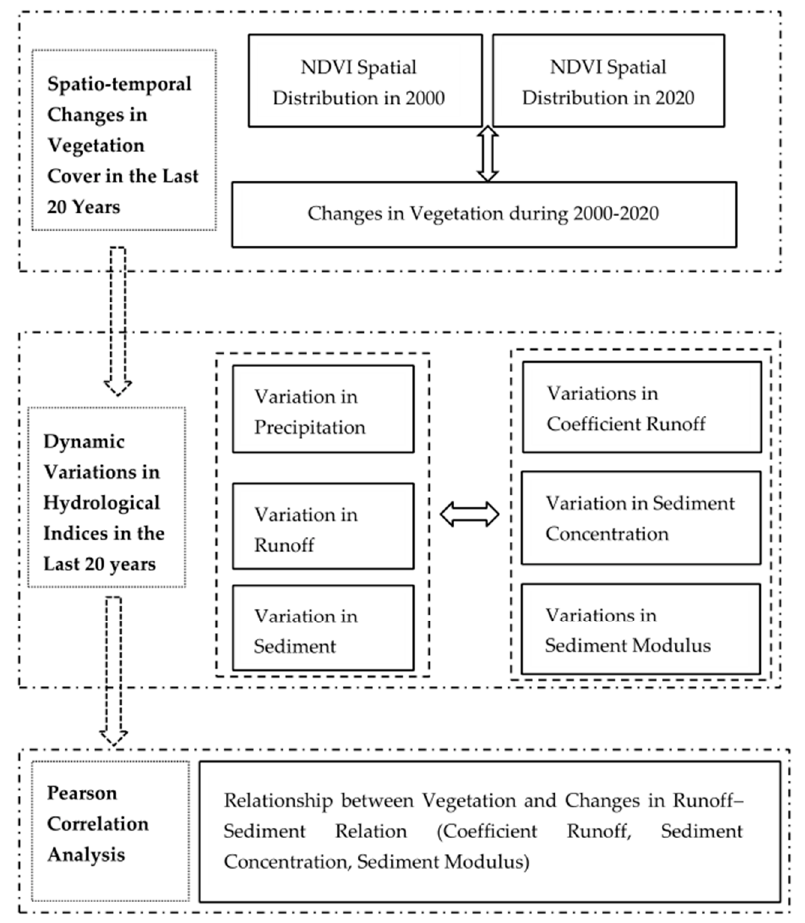
Figure 2. The overall workflow of this study. Table 1. Correspondence between hydrological stations and rivers considered in this study.